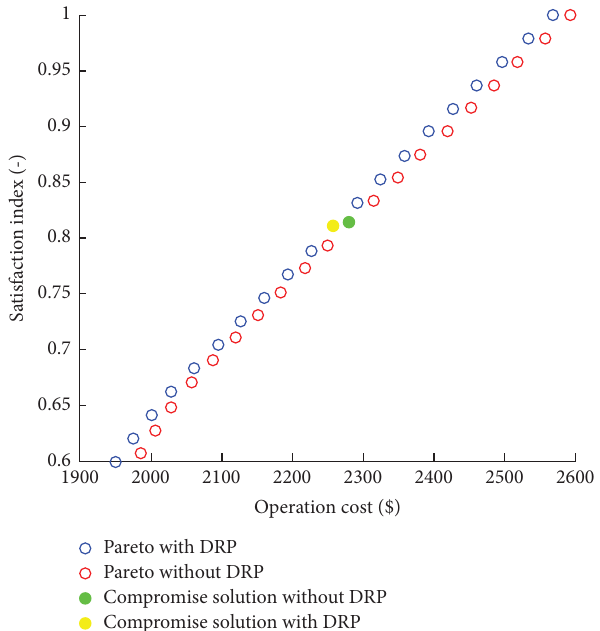
Figure 8: Pareto solutions with/without DRP.